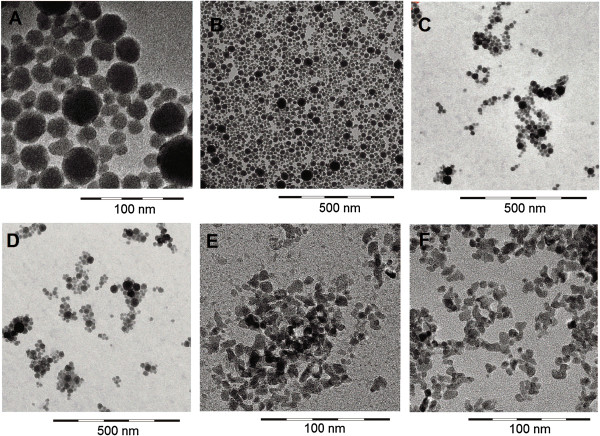
Scanning electron microscopy images of the suspension test materials. A: SiO2.naked, B: SiO2.PEG, C: SiO2.amino, D: SiO2.phosphate, E: ZrO2.TODA, F: ZrO2.acrylate. Note slightly different sets of scales in order to point to the individual characteristics of the respective test materials.